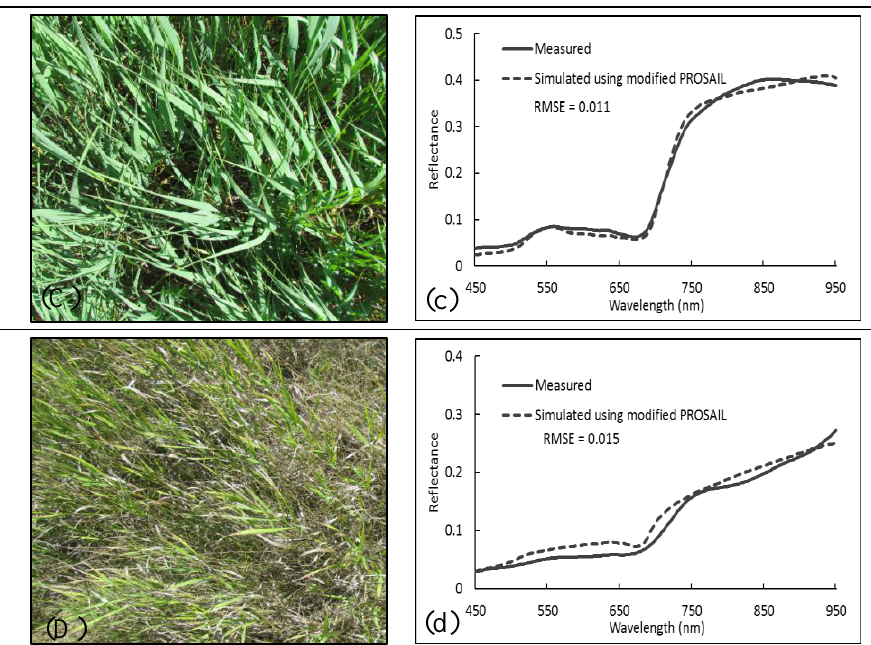
Figure 7. Simulation results of PROSPECT and PROSAIL model. Figure (A) and (B) show leaves at different growth stages and corresponding measured and simulated reflectance are shown in Figure (a) and (b), respectively. Figure (C) and (D) show canopies at different growth stages and corresponding measured and simulated reflectance are shown in Figure (c) and (d), respectively.